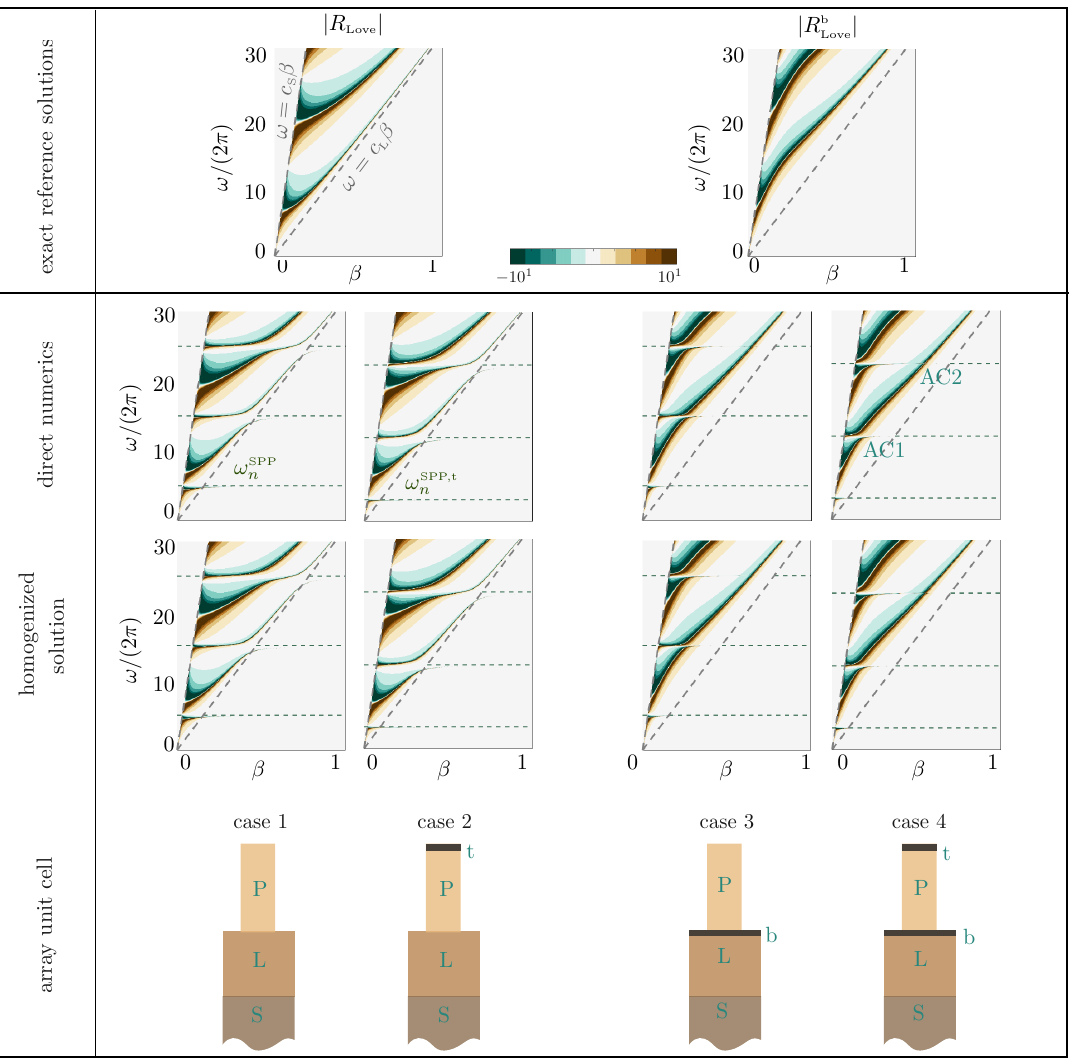
Figure 7. Dispersion relations of guided waves in four configurations of plates from direct numerics and from the homogenized solution (20)–(22); the dispersion relations are revealed by large The exact reference dispersion relations of classical and modified Love waves are given in the top panel for comparison. Dotted lines are a guide for the eye showing light lines for Love waves and asymptotes for SPPs. AC1 and AC2 are avoided crossings magnified in Figure 8. Details of homogenized coefficients and geometrical parameters are given in Tables 2 and